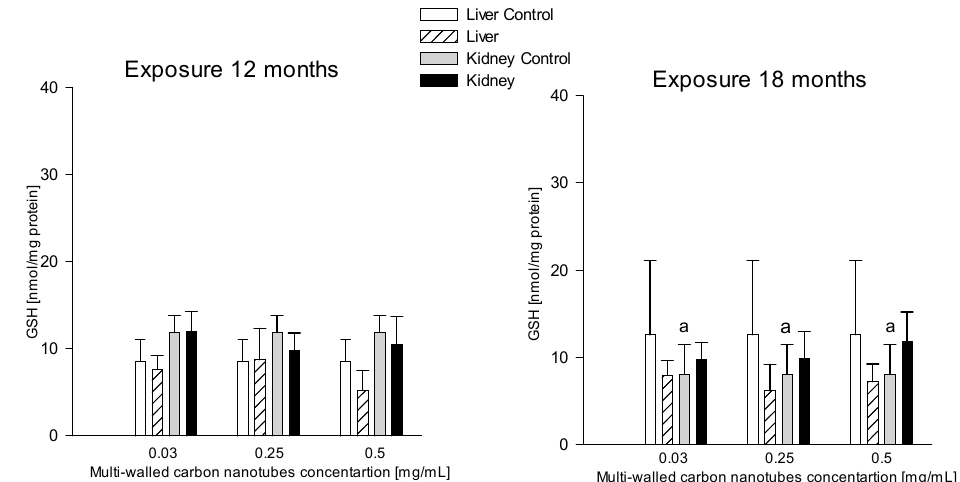
Figure 5. Comparison of reduced glutathione (GSH) concentrations in the liver and kidneys of animals exposed to multi-walled carbon nanotubes for 12 and 18 months. (a)—statistically significant difference for control group at 18 months versus control at 12 months in the kidneys (p = 0.035571 ) .